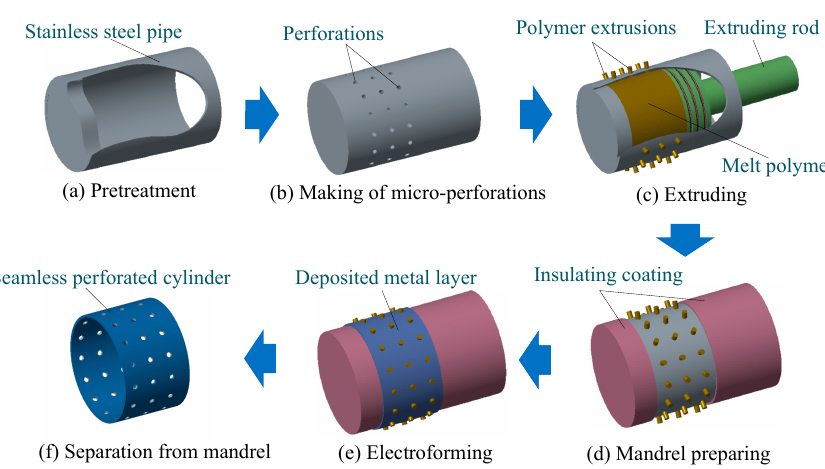
Figure 2. Main procedures of the hybrid technique for manufacture the seamless thin-walled perforated hollow metallic cylinder.